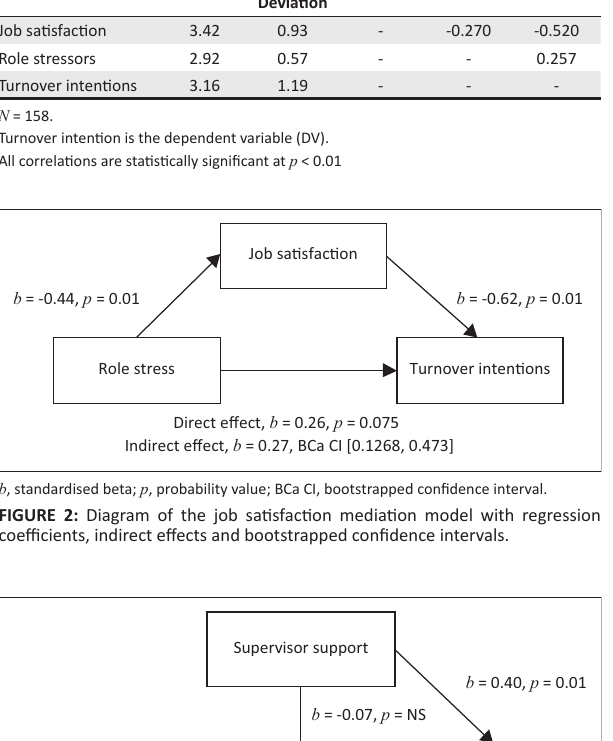
TABLE 5: Means, standard deviations and intercorrelations for job satisfaction, role stressors and turnover intentions. Variable